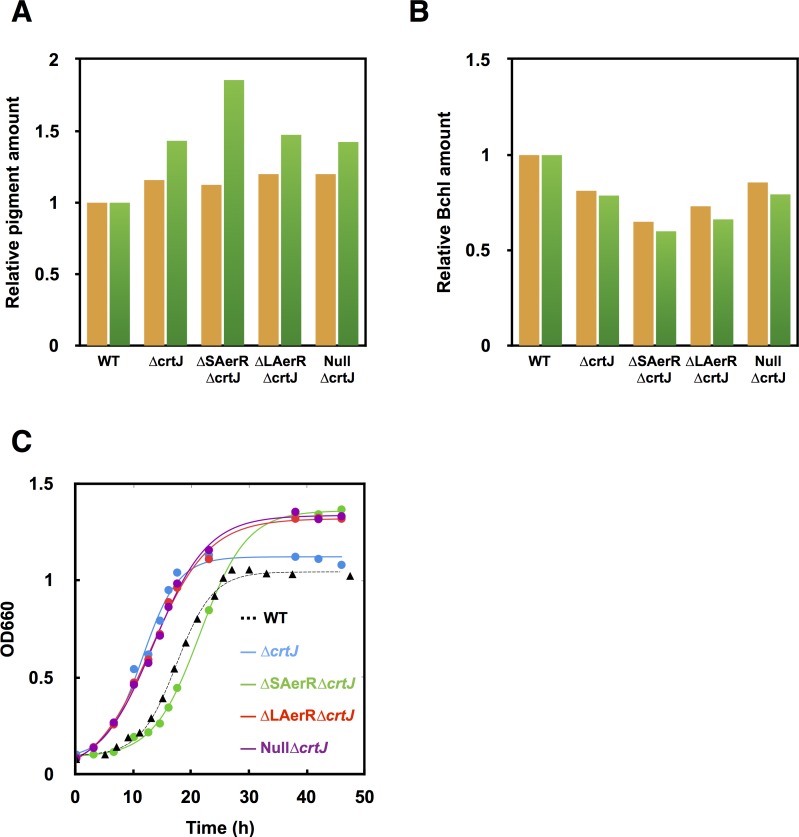
SAerR and LAerR phenotypes are suppressed by a CrtJ null mutation.A crtJ gene deletion was constructed in ∆SAerR, ∆LAerR and ∆AerR mutant strains and then assayed for pigment production and photosynthetic growth. Bar graph of carotenoid (yellow bar) and bacteriochlorophyll (green bar) pigments present in dark semi-aerobically grown (A) or photosynthetically grown cells (B) harvested at late-exponential phase (OD = 0.6 to 0.7). (C) Growth curve of ∆crtJ (blue), ∆SAerR/∆crtJ (green), ∆LAerR/∆crtJ (red), Null/∆crtJ (purple), and WT control (black triangle) when shifted from dark aerobic to a light anaerobic conditions.